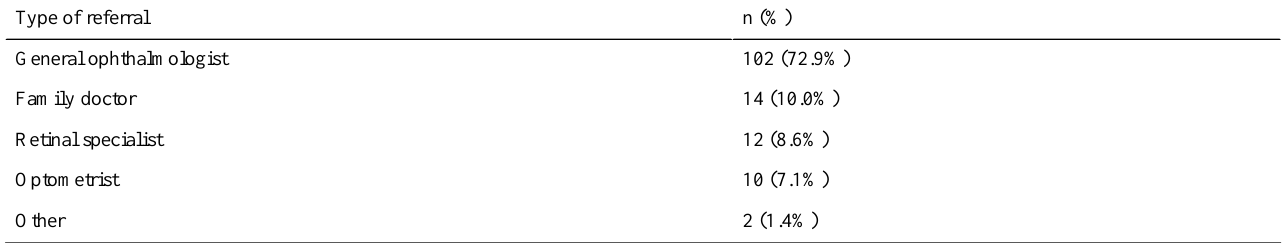
Table 2. Number of teleopthalmology clients per referral type